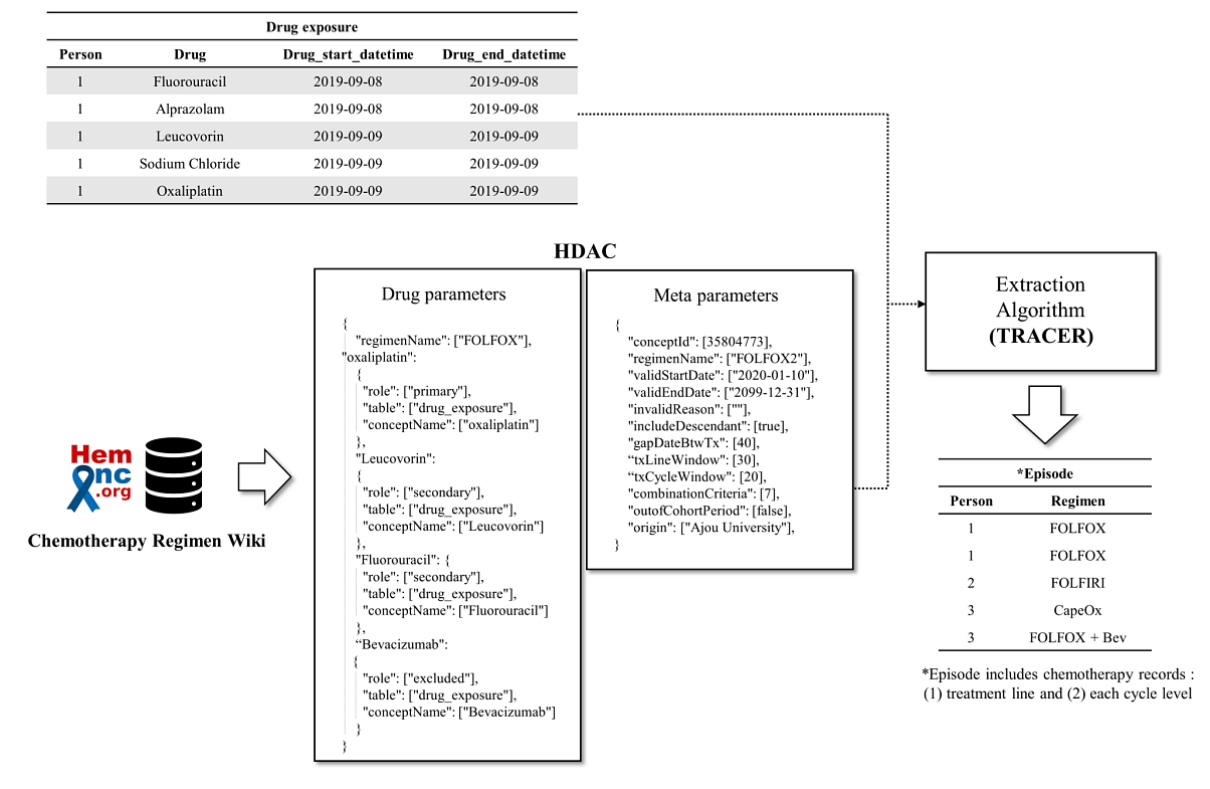
Figure 1. Schematic workflow of the chemotherapy episode extraction. A total of 1506 regimen protocols from HemOnc (a web-based open-source database of cancer chemotherapy regimens) were parameterized as JSON structured data, which is termed HDAC. The JSON file and single drug exposure records in the OMOP-CDM database were instantiated as input data for an algorithm. The TRACER identified chemotherapy episodes by leveraging the parameters from HDAC. The chemotherapy episodes were curated in the episode table, which is an oncology module in the OMOP-CDM. Bev: bevacizumab; CDM: Common Data Model; FOLFIRI: fluorouracil, leucovorin, and irinotecan; FOLFOX: fluorouracil, leucovorin, and oxaliplatin; HDAC: Hierarchical Description for Administration of Chemotherapy; JSON: JavaScript Object Notation; OMOP: Observational Medical Outcomes Partnership; TRACER: Tool for Regimen-level Abstraction of Chemotherapy Episode